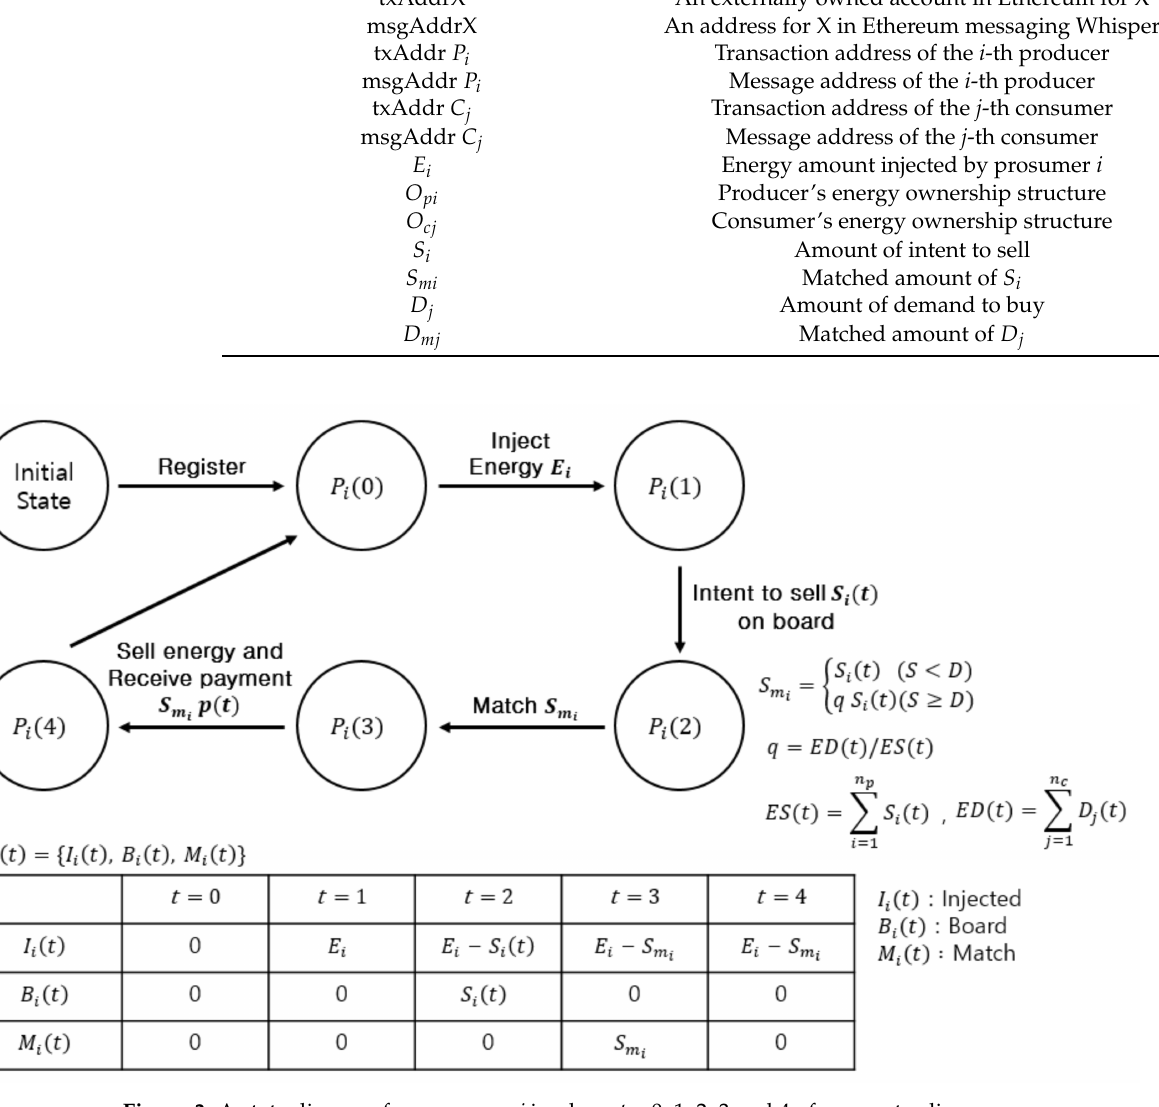
Figure 3. A state diagram for prosumer i in phase t = 0, 1, 2, 3 and 4 of energy